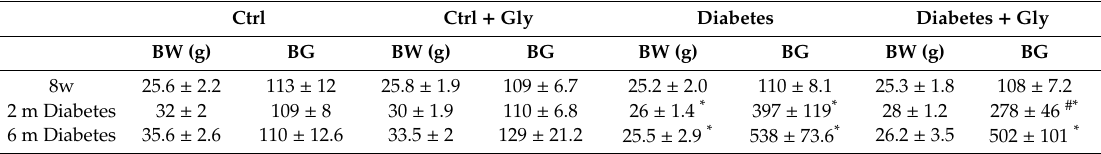
Table 1. Data are mean ± standard deviation.* p < 0.05 vs ctrl, # p < 0.05 Vs. Diabetes. Ctrl, control. Diabetes, Gly,